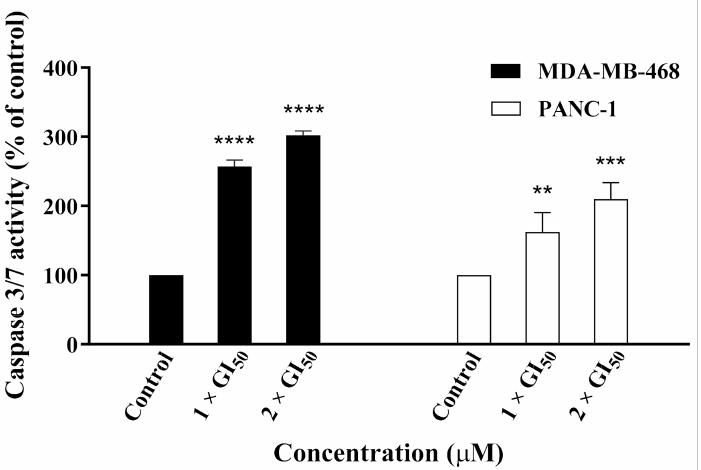
Figure 9. Caspase-3/7 activity of MDA-MB-468 and PANC-1 cells after 24 h of treatment with 19 at concentrations of 1 × GI 50 and 2 × GI 50 . The experiment was repeated at least three times. Bars and error bars refer to the mean ± SD. ** p < 0.01 vs. control, *** p < 0.001 vs. control, **** p < 0.0001 vs.